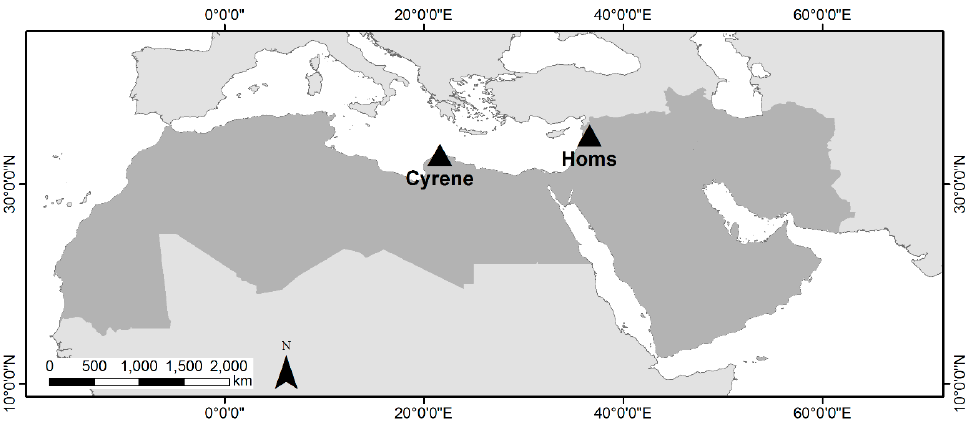
Figure 1. Endangered Archaeology of the Middle East and North Africa (EAMENA) study area (highlighted in grey) and the location of the case studies discussed in this paper.